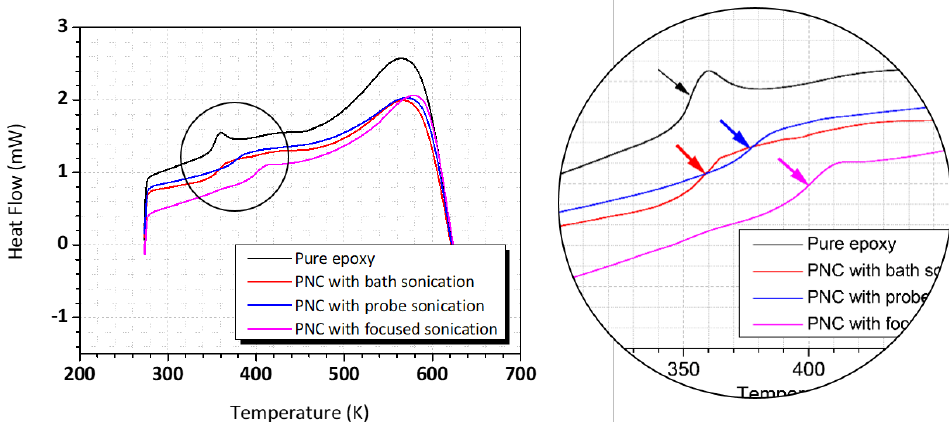
Figure 10. DSC curve of the 1.0 wt.% TiO 2 –epoxy nanocomposites in accordance with the sonication method conducted within the range of 200–700 K.